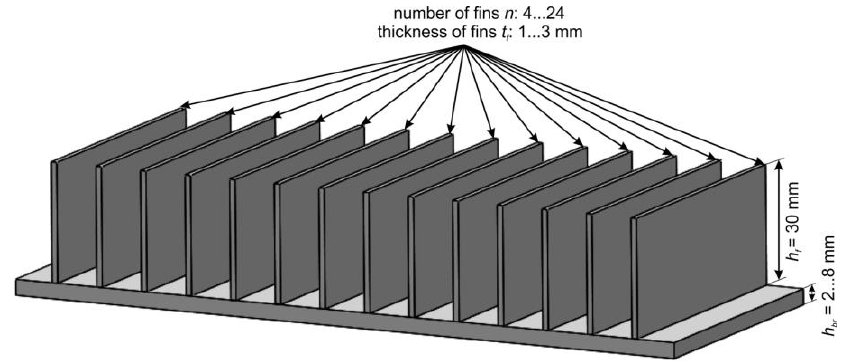
Figure 8. Model of the studied radiator with a variable number and thickness of fins.